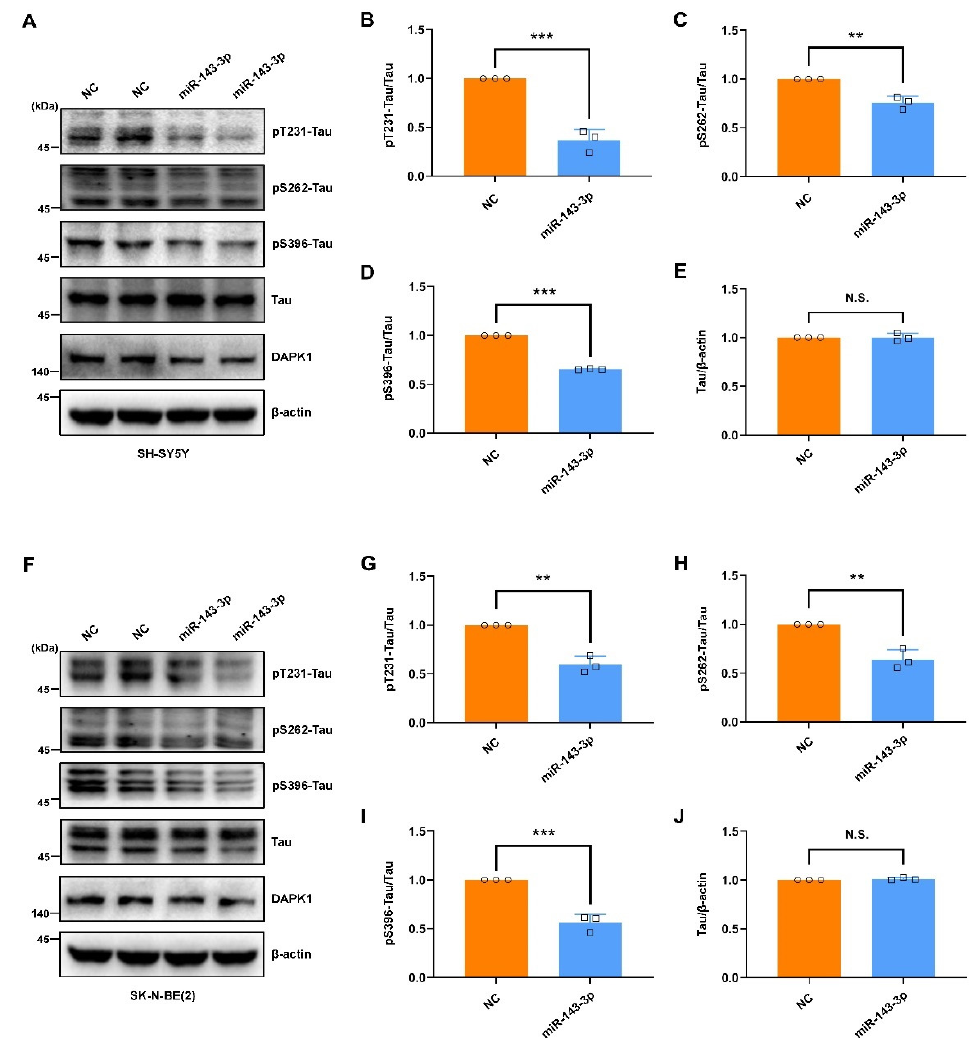
Figure 3. miR-143-3p inhibits tau phosphorylation. ( A ) SH-SY5Y cells were transfected with miR- 143-3p or NC for 48 h, and the levels of tau phosphorylated at Thr231, Ser262, and Ser396, total tau, and DAPK1 were analyzed by immunoblotting. ( B – E ) Relative quantification was performed using ImageJ software, and the results are presented as a histogram. ( F ) SK-N-BE(2) cells were transfected with miR-143-3p or NC for 48 h, and the levels of tau phosphorylated at Thr231, Ser262, and Ser396, total tau, and DAPK1 were analyzed by immunoblotting. ( G – J ) Relative quantification was performed using ImageJ software, and the results are presented as a histogram. The data (circles and squares) are presented as the mean ± SD of three independent experiments (** p < 0.01, *** p < 0.001, N.S., not significant).